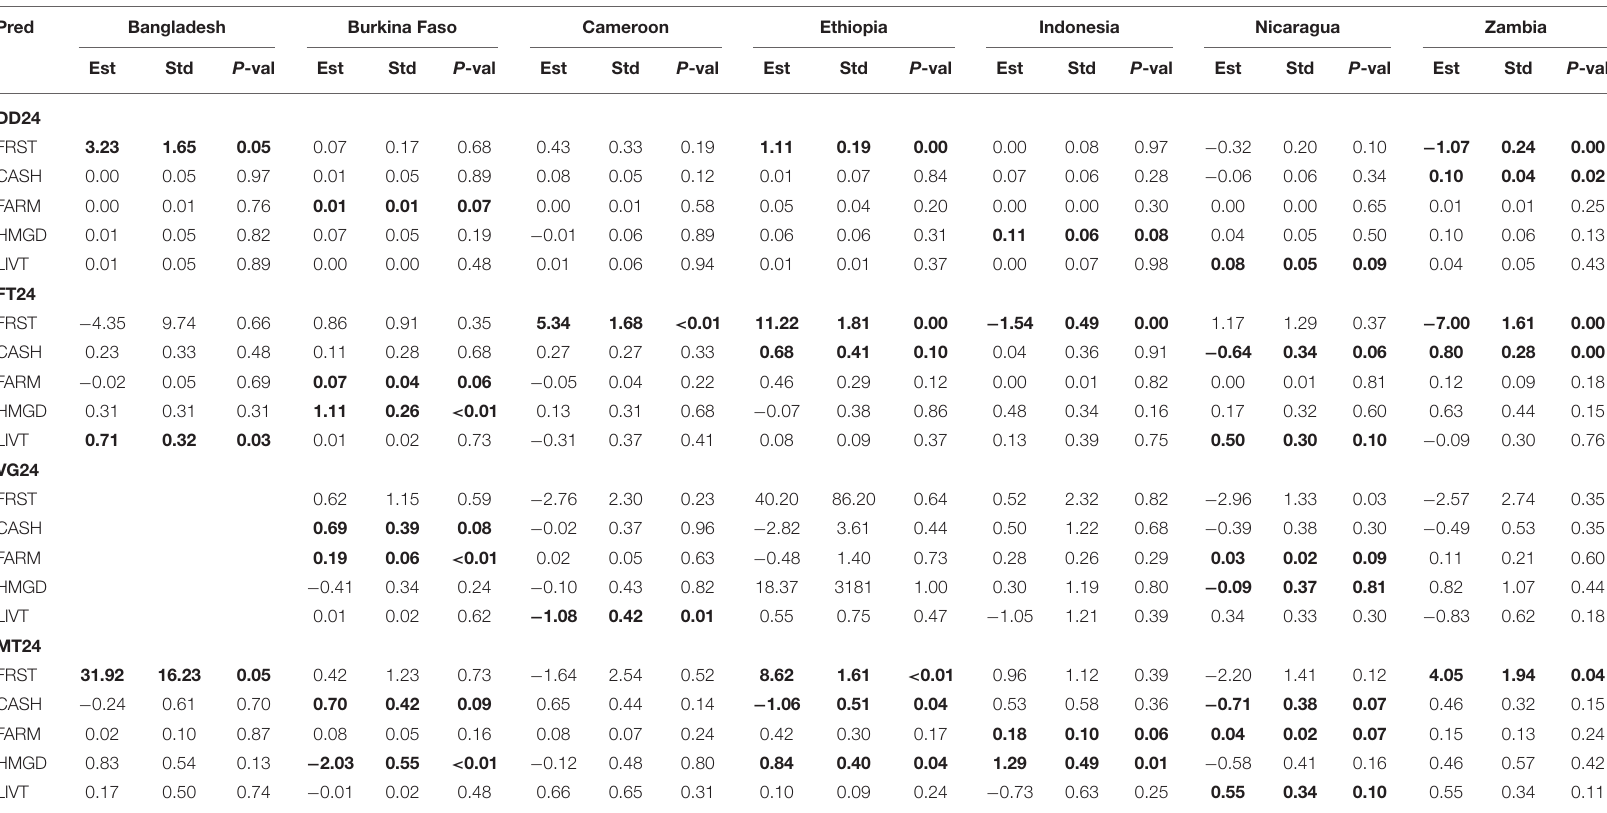
TABLE 3 | Estimates and their confidence intervals and associated P -values for the predictors of household dietary diversity scores (DD24), fruit consumption (FT24), vegetable consumption (VG24), and meat (and other animal product excluding dairy) consumption (MT24) for Bangladesh (BAN), Burkina Faso (BUR), Cameroon (CAM), Ethiopia (ETH), Indonesia (IND), Nicaragua (NIC), and Zambia (ZAM).